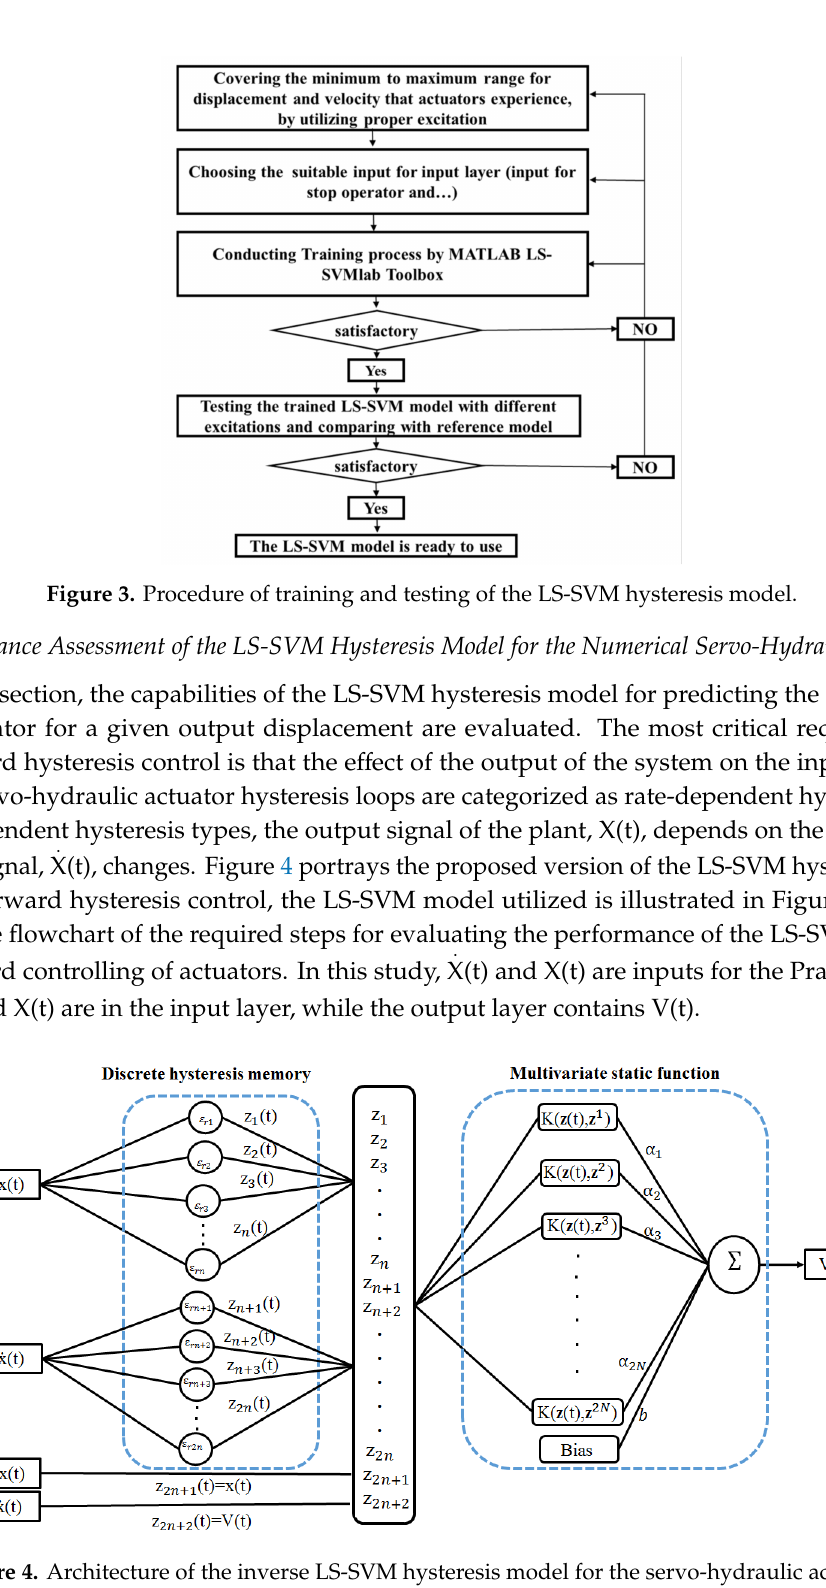
Figure 4. Architecture of the inverse LS-SVM hysteresis model for the servo-hydraulic